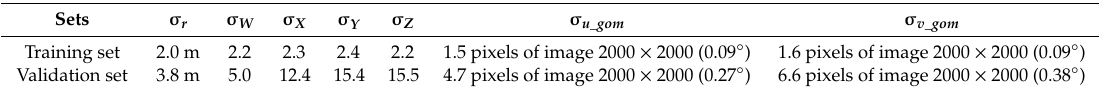
Table 2. Errors of coordinates and rotation angles for the drone camera.